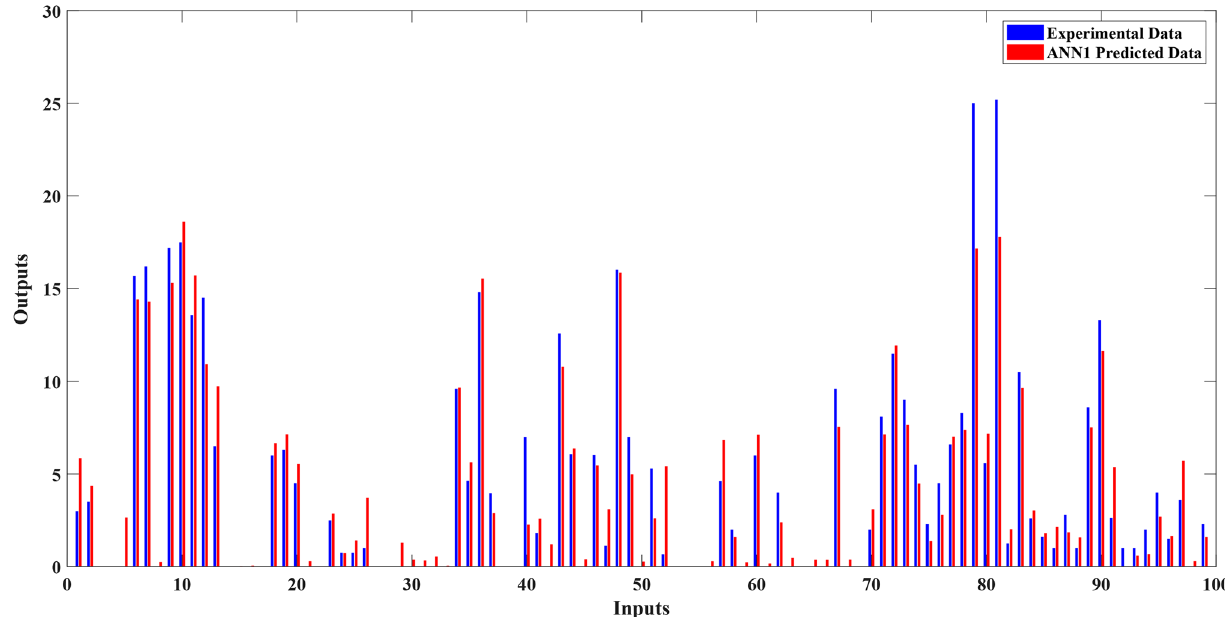
Fig. 26 The performance evaluation of the Model No.1 (ANN 1) based on the predicted and experimental data